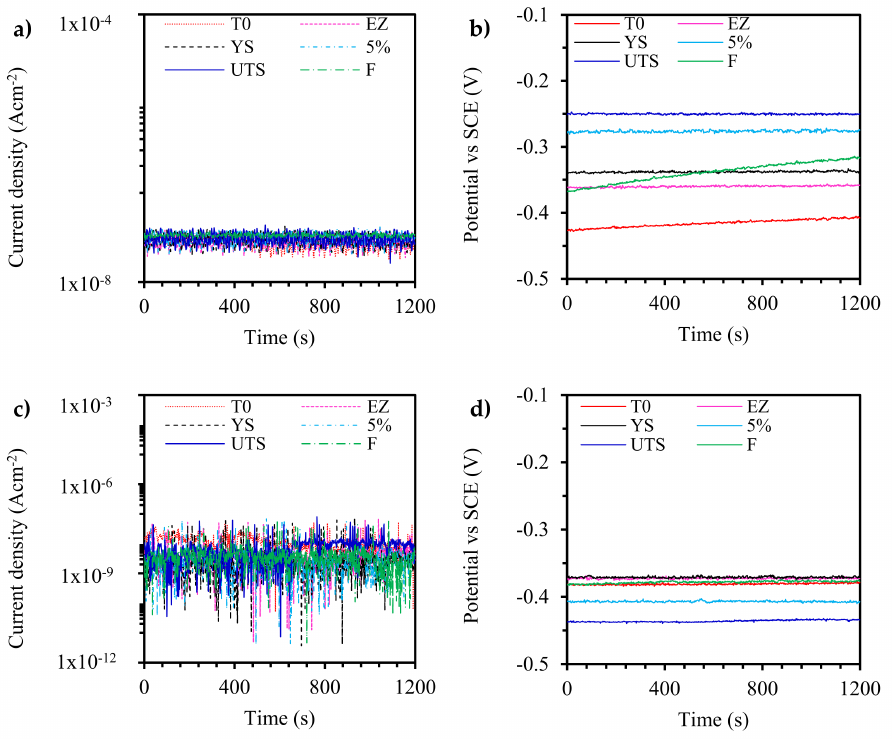
Figure 12. The current and potential time series from the EN measurements for the ER310 weld in NaOH ( a , b ) RT and ( c , d ) 80 ◦